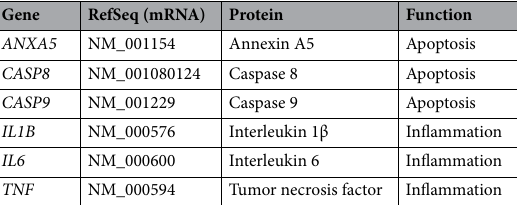
Table 2. Markers used in qRT-PCR for gene expression